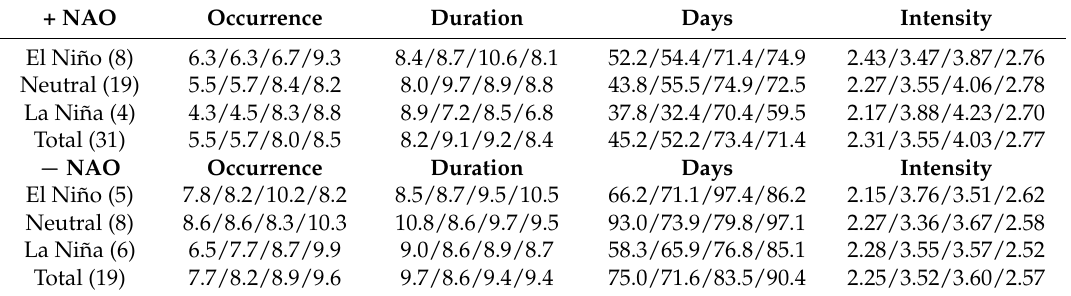
Table A2. As in Table A1, except for NH blocking events per year by season (Su/F/W/Sp).